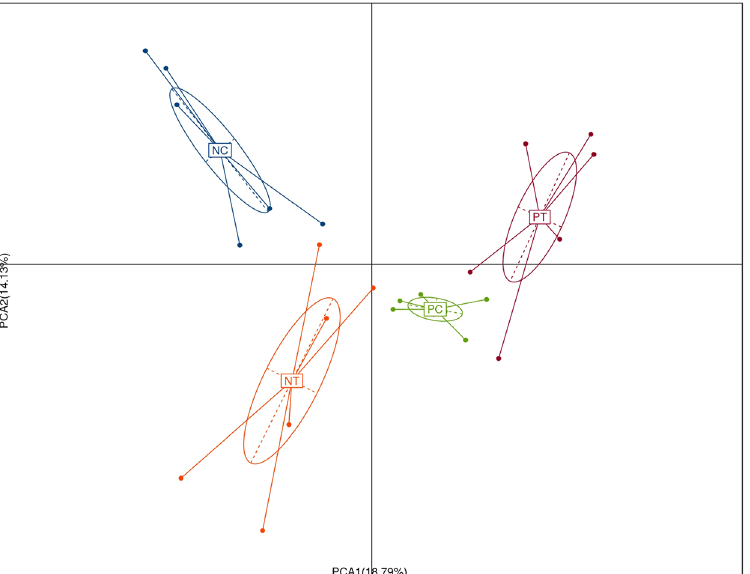
Figure 8. Effects of dietary E . faecium 11181 on cecal microbiota β -diversity (community similarity) of broilers challenged with NE at d 26 (n = 6). Principal component analysis (PCA) plot of samples in different treatment groups using the abundance information at the genus level. NC = Non-NE-infected + no E. faecium treatment, NT = non-NE-infected + E. faecium treatment, PC = NE-infected + no E. faecium treatment, PT = NE- infected + E. faecium treatment.